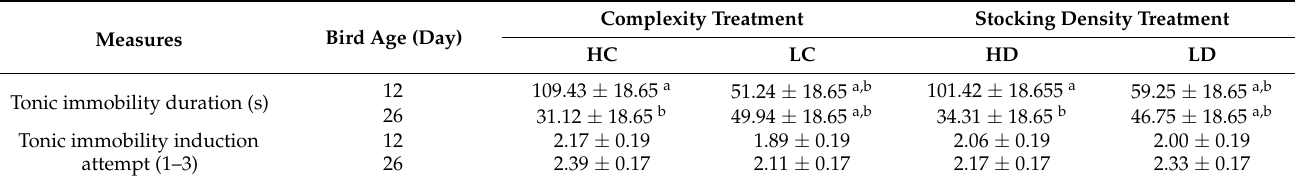
Table 6. Least squares mean estimates for tonic immobility duration (s ± SEM; 0–300 s) and induction attempts (1–3) for broiler chickens kept in high-complexity (HC), low-complexity (LC), high-density (HD), and low-density (LD) treatments in Experiment 1 on days 12 and 26 ( n =